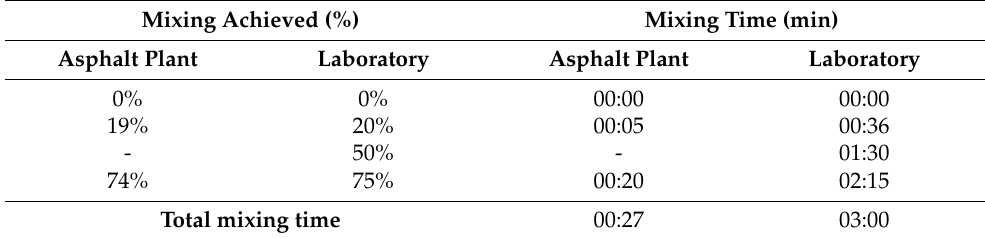
Table 2. Times for adding cellular capsules into the asphalt during the mixing stage. Mixing Achieved (%) Mixing Time (min) Asphalt Plant Laboratory